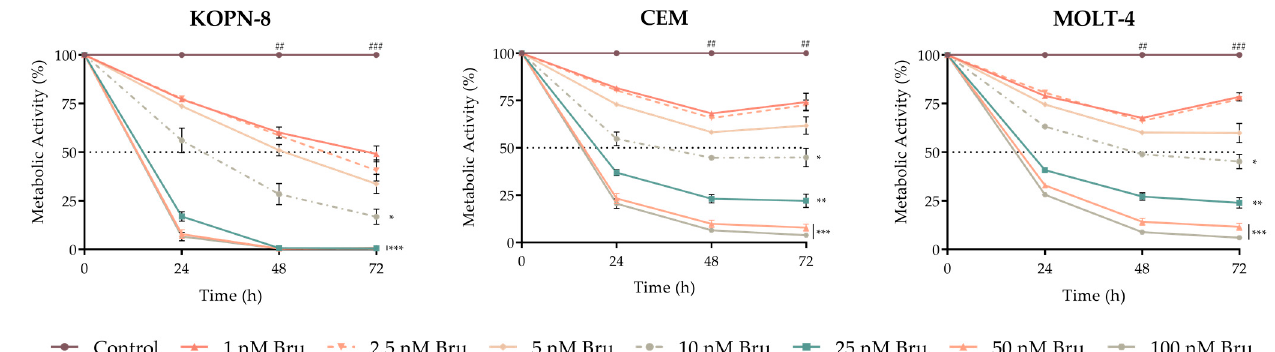
Figure 3. Dose–response curves of brusatol (Bru) in acute lymphoblastic leukemia cell lines. Cells were incubated with increasing concentrations of brusatol for 72 h. Data are expressed in percentage (%) normalized to control and represented as mean ± SEM obtained from at least 5 independent experiments. * p < 0.05, ** p < 0.01, *** p < 0.001 comparing with untreated cells (control); ## p < 0.01, ### p < 0.001 comparing with 0 h.